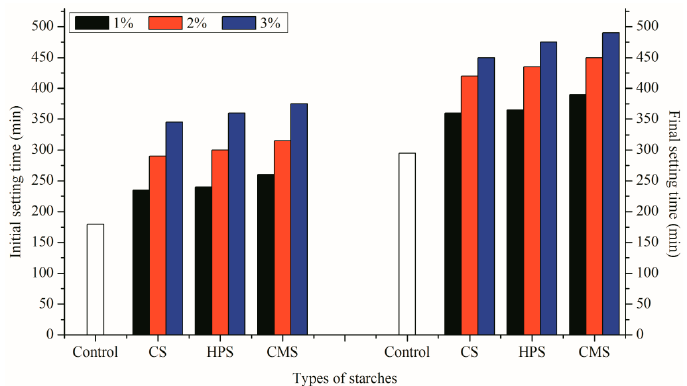
Figure 3. The setting time of control and AAC with different dosages of starches at 85 °C .